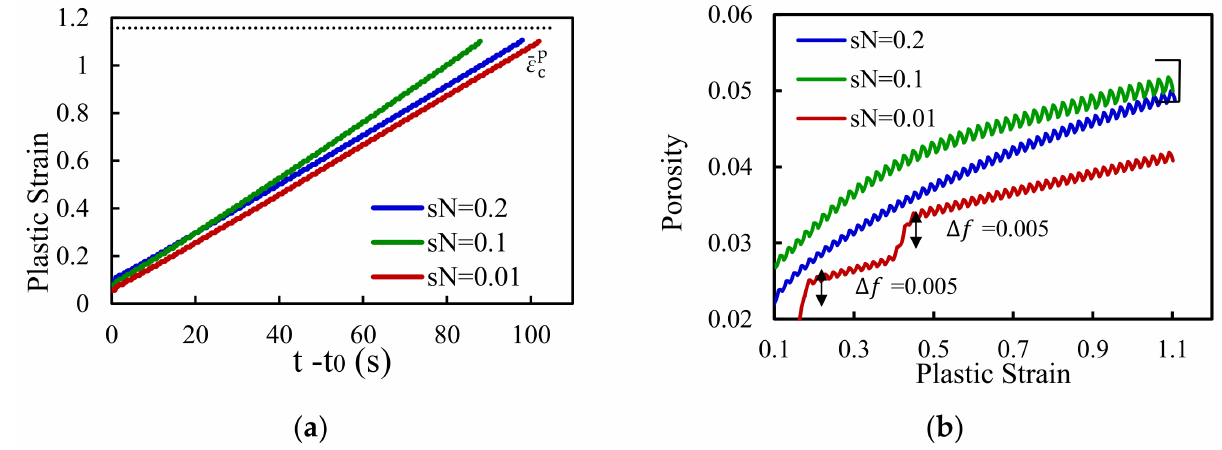
Figure 19. ( a ) Plastic strain evolution throughout a single propagation for the three values of s N ( b ) Porosity build-up for the same propagations referred before. Results are presented in natural